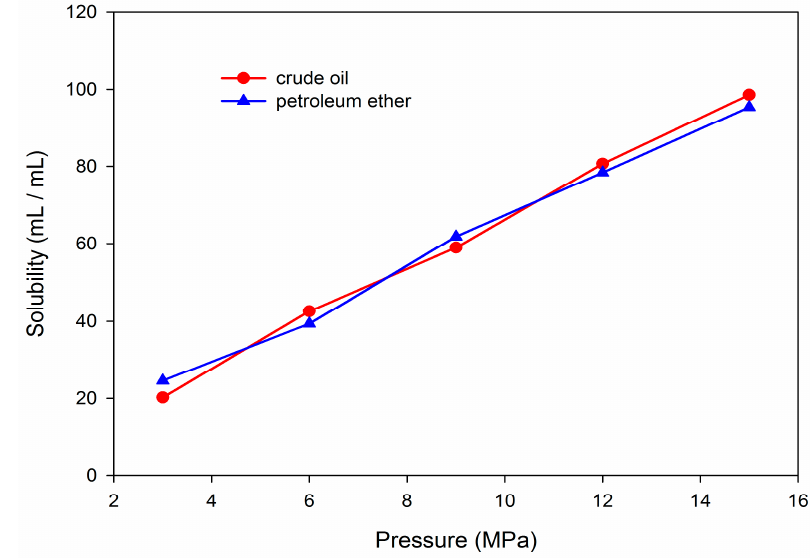
Figure 6. Solubility of CO 2 in the diluted crude oil with petroleum ether and undiluted crude oil under different pressures.